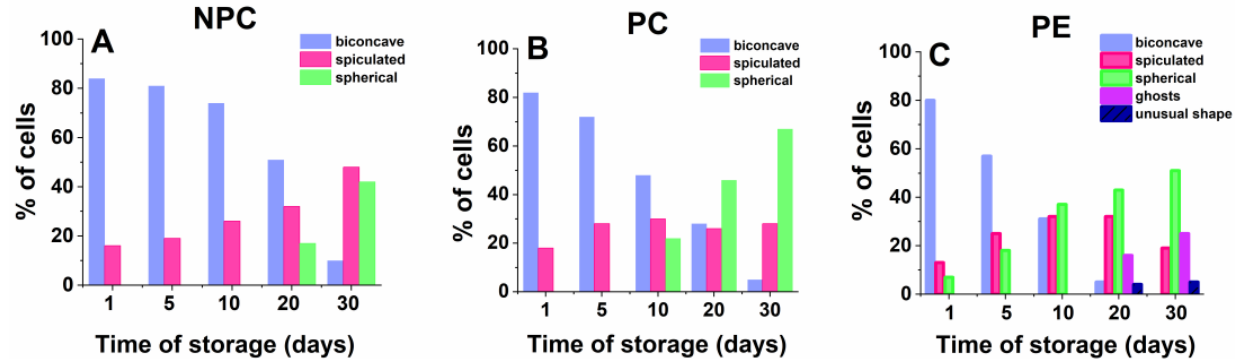
Figure 2. Histogram of the relative contribution of RBCs assigned to the main morphological classes, along with the senescence of cells derived from healthy non-pregnant controls (NPCs, ( A )); healthy pregnant controls (PCs, ( B )), and patients with preeclampsia (PE, ( C )). Each morphological type is presented as a percentage of the total number of cells.